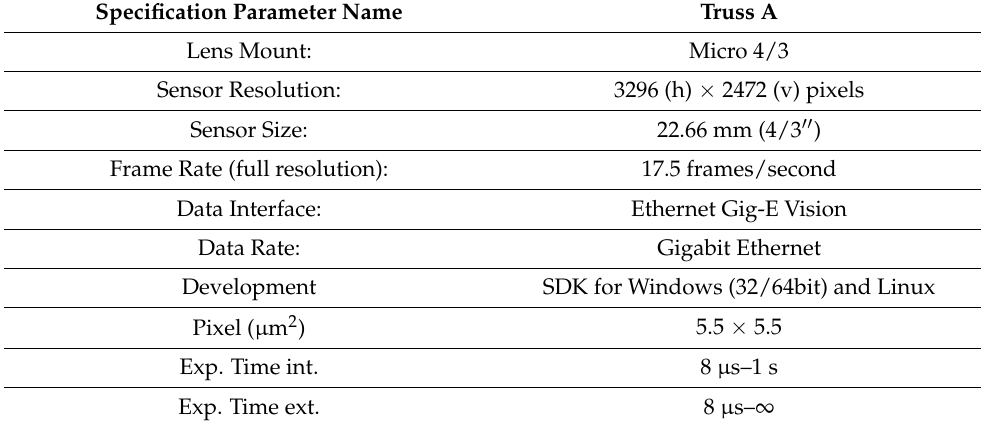
Table A1. Camera